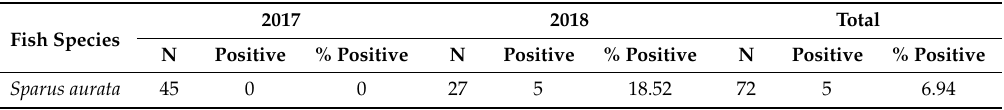
Table 8. Mycobacterium prevalence in the cultured fish S. aurata from the Mediterranean Sea fish farm. The results are based on PCR targeting 16S rRNA segments.